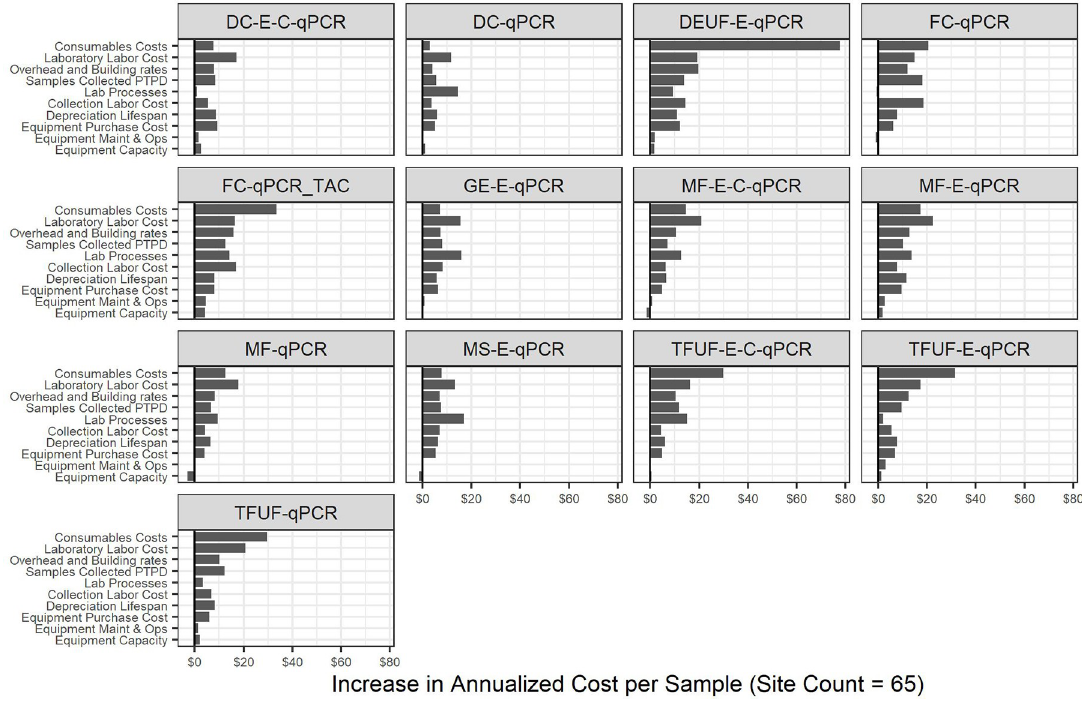
Fig 4. Sensitivity analysis reflecting the impact of a 20% increase in the relevant baseline value and its impact on the annualized cost per sample. For example, laboratory labor cost multiplies the salary values by 1.2 to increase the total; depreciation lifespan multiplies the number of years by 0.8, which thus increases costs due to faster replacement. All values in 2019 US dollars. Values represent an example scenario with sixty-five sites and bi-weekly sampling ( i . e ., 26 samples per year per site). Increases are calculated as the difference between the mean baseline and 20% adjusted scenarios. DEUF = dead end ultrafiltration. FC = filter cartridge. GE = grab enrichment. MF = membrane filtration. MS = Moore swab. TFUF = tangential flow